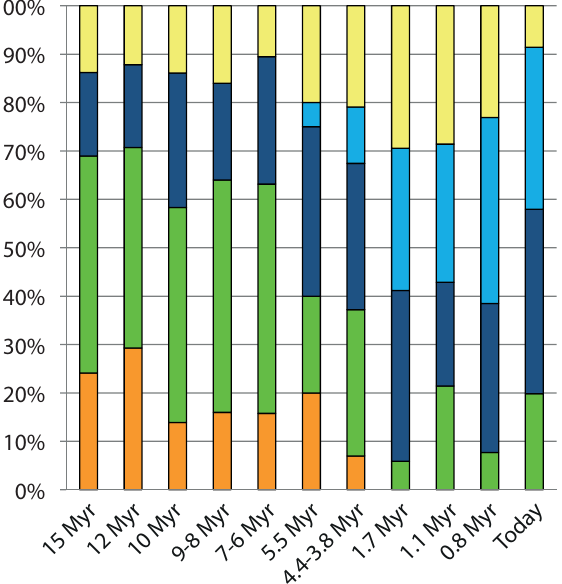
Fig. 6. Proportion of elements ascribed to major vegetation types from fossil plant assemblages and the modern flora of Iceland. Elements are categorized as meridio-nemoral (orange), nemoral (green), boreal (dark blue), Arctic–alpine (light blue), and gener- alists (yellow) based on their specific Köppen